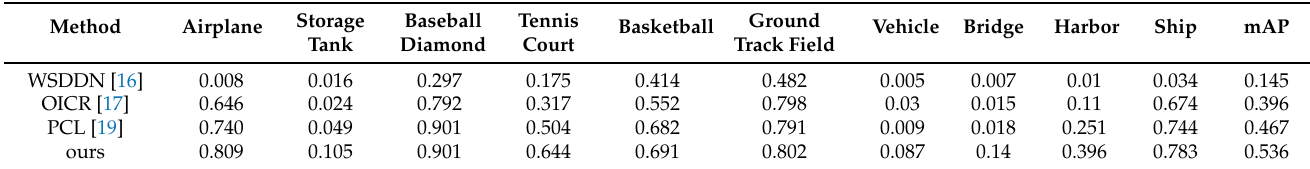
Table 2. mAP on the NWPU VHR-10 test set.